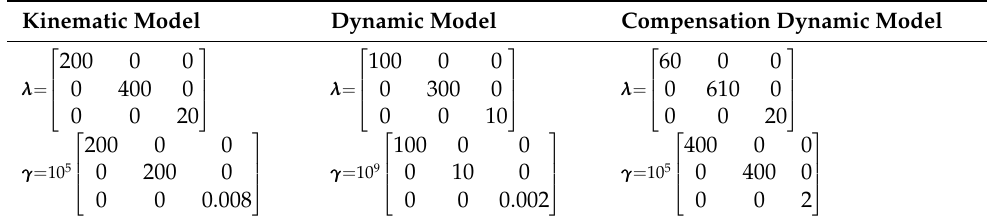
Table 2. The gains for the following task.